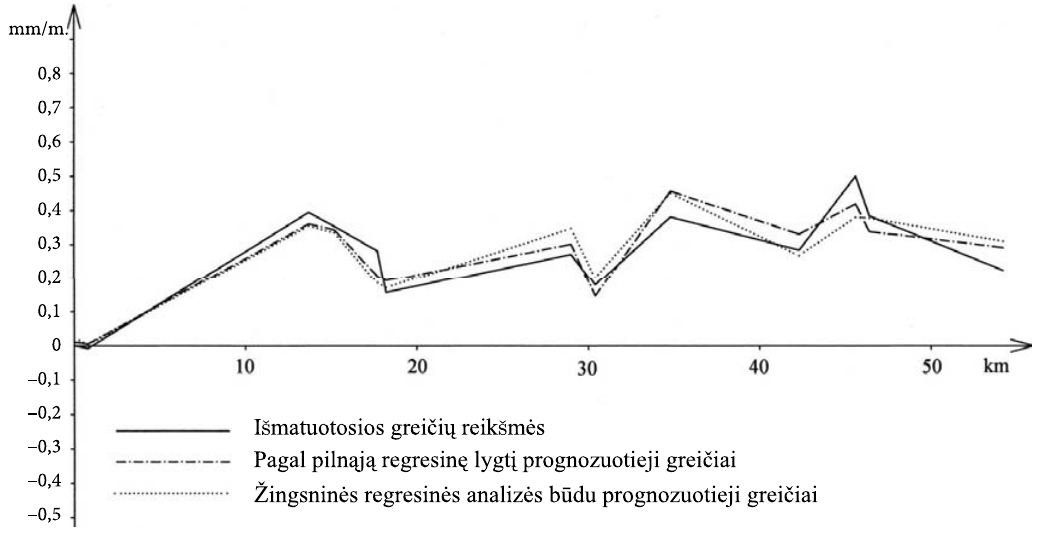
Fig 1. Prognoses and measured vertical movements of Earth surface during 1936–1975